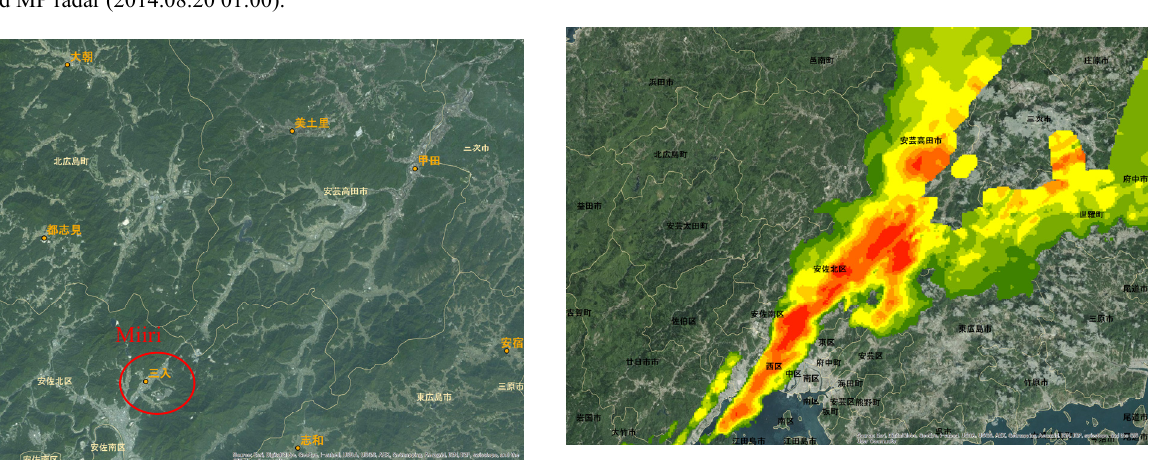
Figure 7. Information on observation point in the vicinity of JMA AMeDAS of Hiroshima Prefecture.